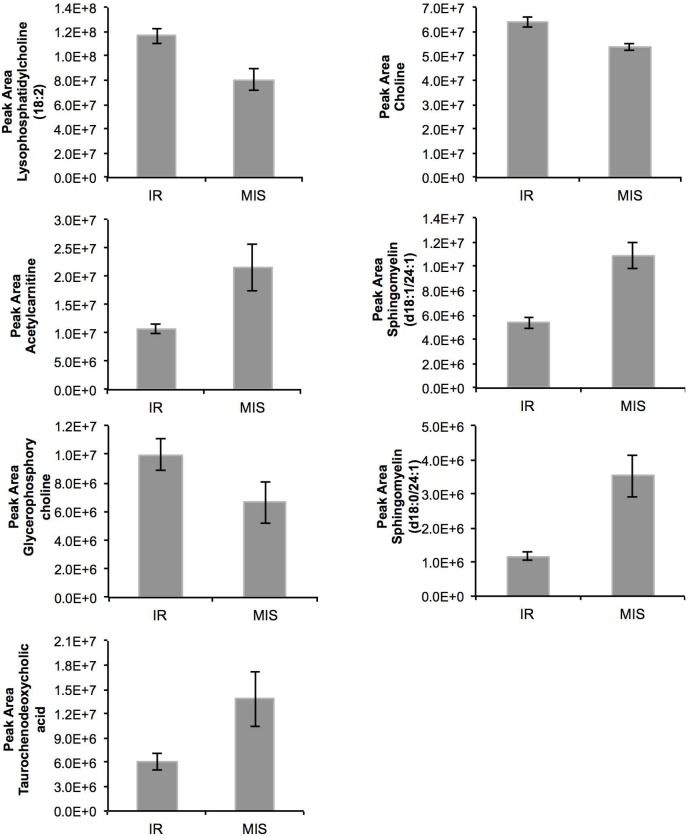
Plasma response of the (putatively) identified biomarkers of insulin resistance in veal calves.The chromatographic peak area is a measure of the blood plasma concentration. MIS = moderately insulin sensitive veal calves (n = 7). IR = insulin resistant veal calves (n = 7). Further details of these two groups are given in Table 1. Error bars represent SEM.